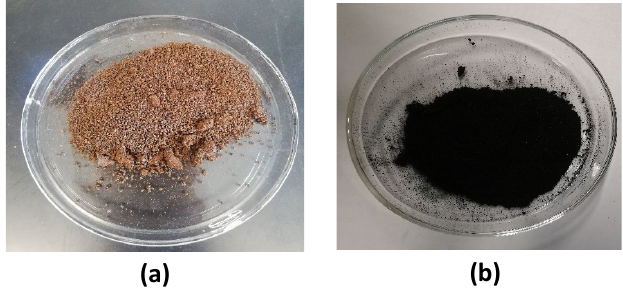
Figure 1. ( a ) Ground and sieved RSS with particle sizes of 0.1–0.25 mm dried at 105 °C ( b ) RSS AC activated by K 2 CO 3 and carbonized at 800 °C for 180 min.